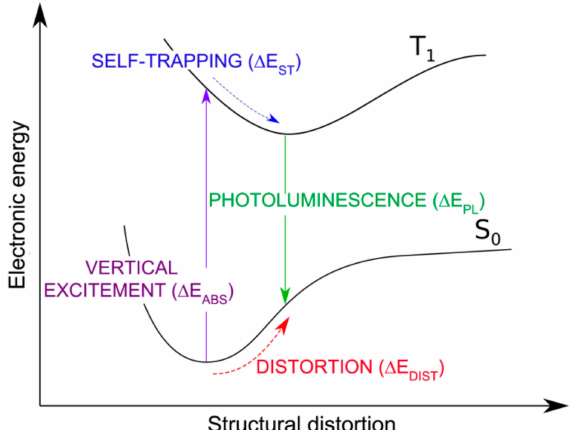
Figure 8. Schematic representation of the S 0 -T 1 excitation ( ∆ E ABS ), exciton self-trapping ( ∆ E ST ) and emission or photoluminescence ( ∆ E PL ) energies for 2D-WSe 2